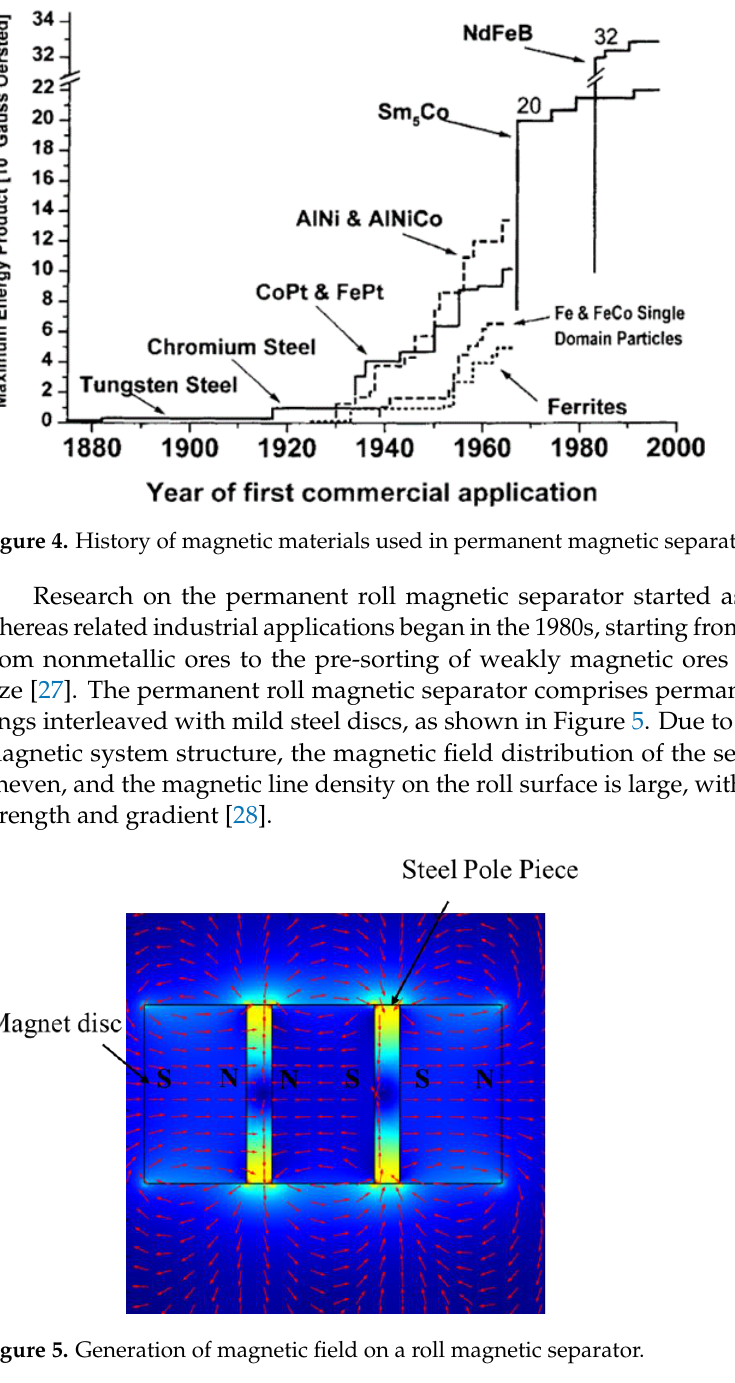
6 of 20 Figure 3. Structure diagram of CTG permanent magnet double-barrel dry magnetic separator: 1— electric vibration feeder; 2—stepless governor; 3—electric motor; 4—upper roller; 5, 7—circular magnetic deficiency system; 6—lower roller; 8—box [23]. 2.3. Dry Permanent Roll Magnetic Separator